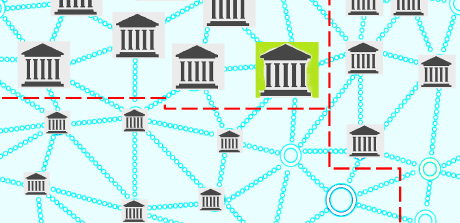
Figure 2. Subnetwork C l